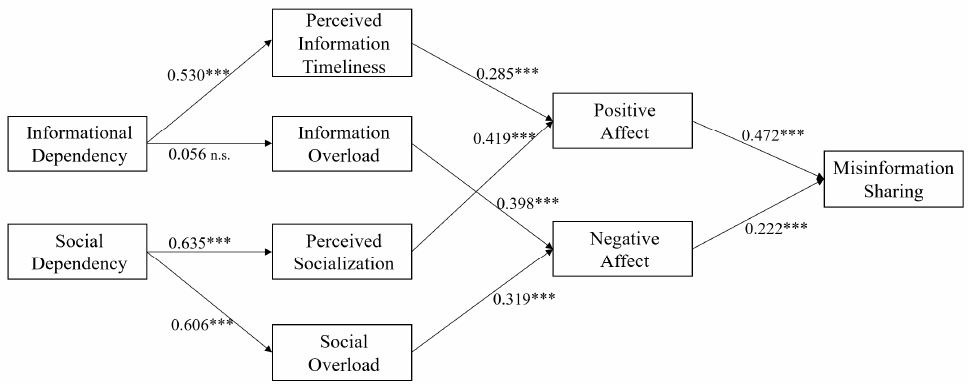
Figure 2. Results of data analysis. *: p < 0.05; **: p < 0.01; ***: p < 0.001; n.s.: not significant.